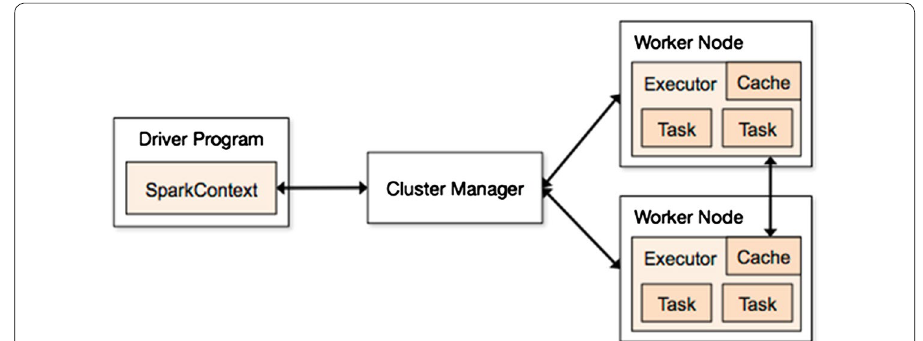
Table 3 The result of standardization The record before